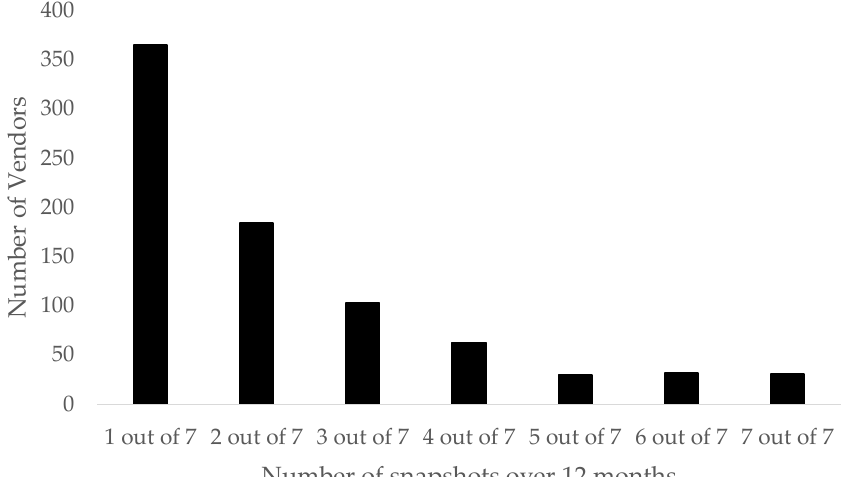
Figure 3. The number of vendors available across the seven snapshots (12 months) of data collection.